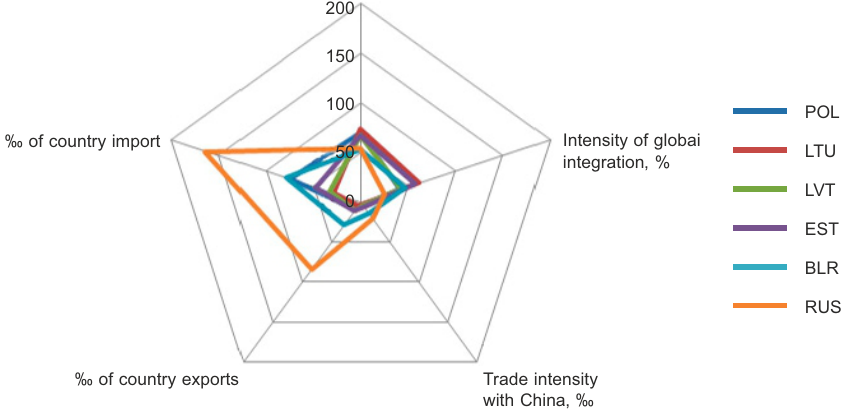
Fig. 6. Evaluation of the potential of researched countries as participants of the NSR Source : own calculation based on IMF (2011, 2015, 2016), World Bank